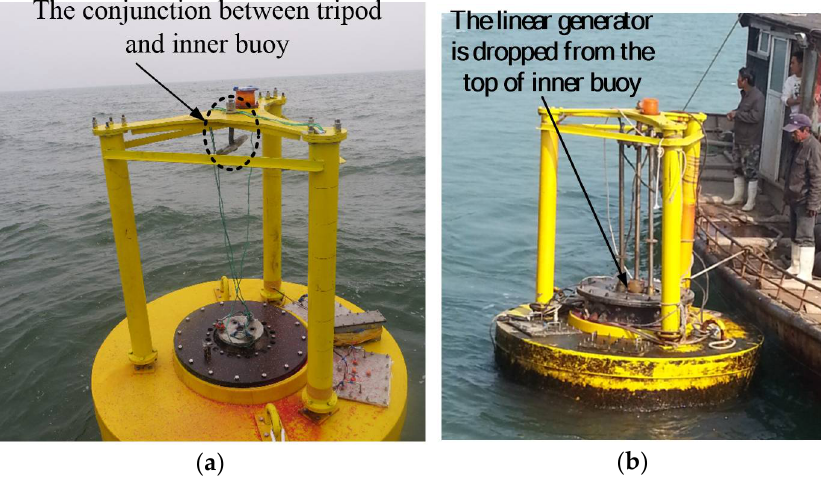
Figure 14. Tests of ocean wave power generation system. ( a ) The first test; ( b ) The second test.